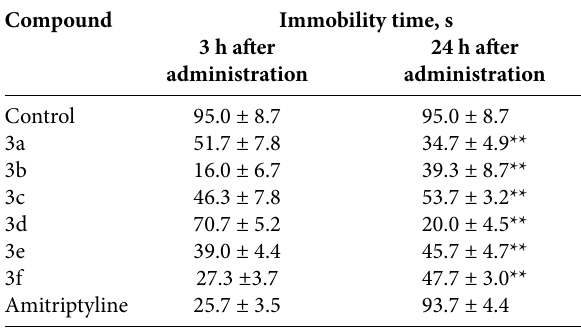
Table 1. Antidepressant activity of compounds 3a-f in forced swim test (FST).